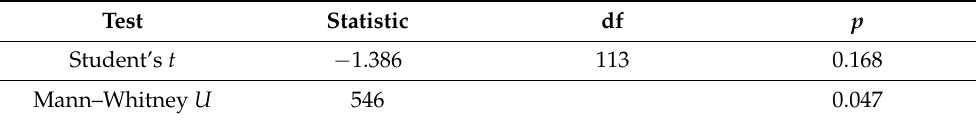
Table 2. Mean AFIR among different SCC subtypes. Table 4. Independent samples comparisons (Absent, Present) for the variable “Fibrosis”.